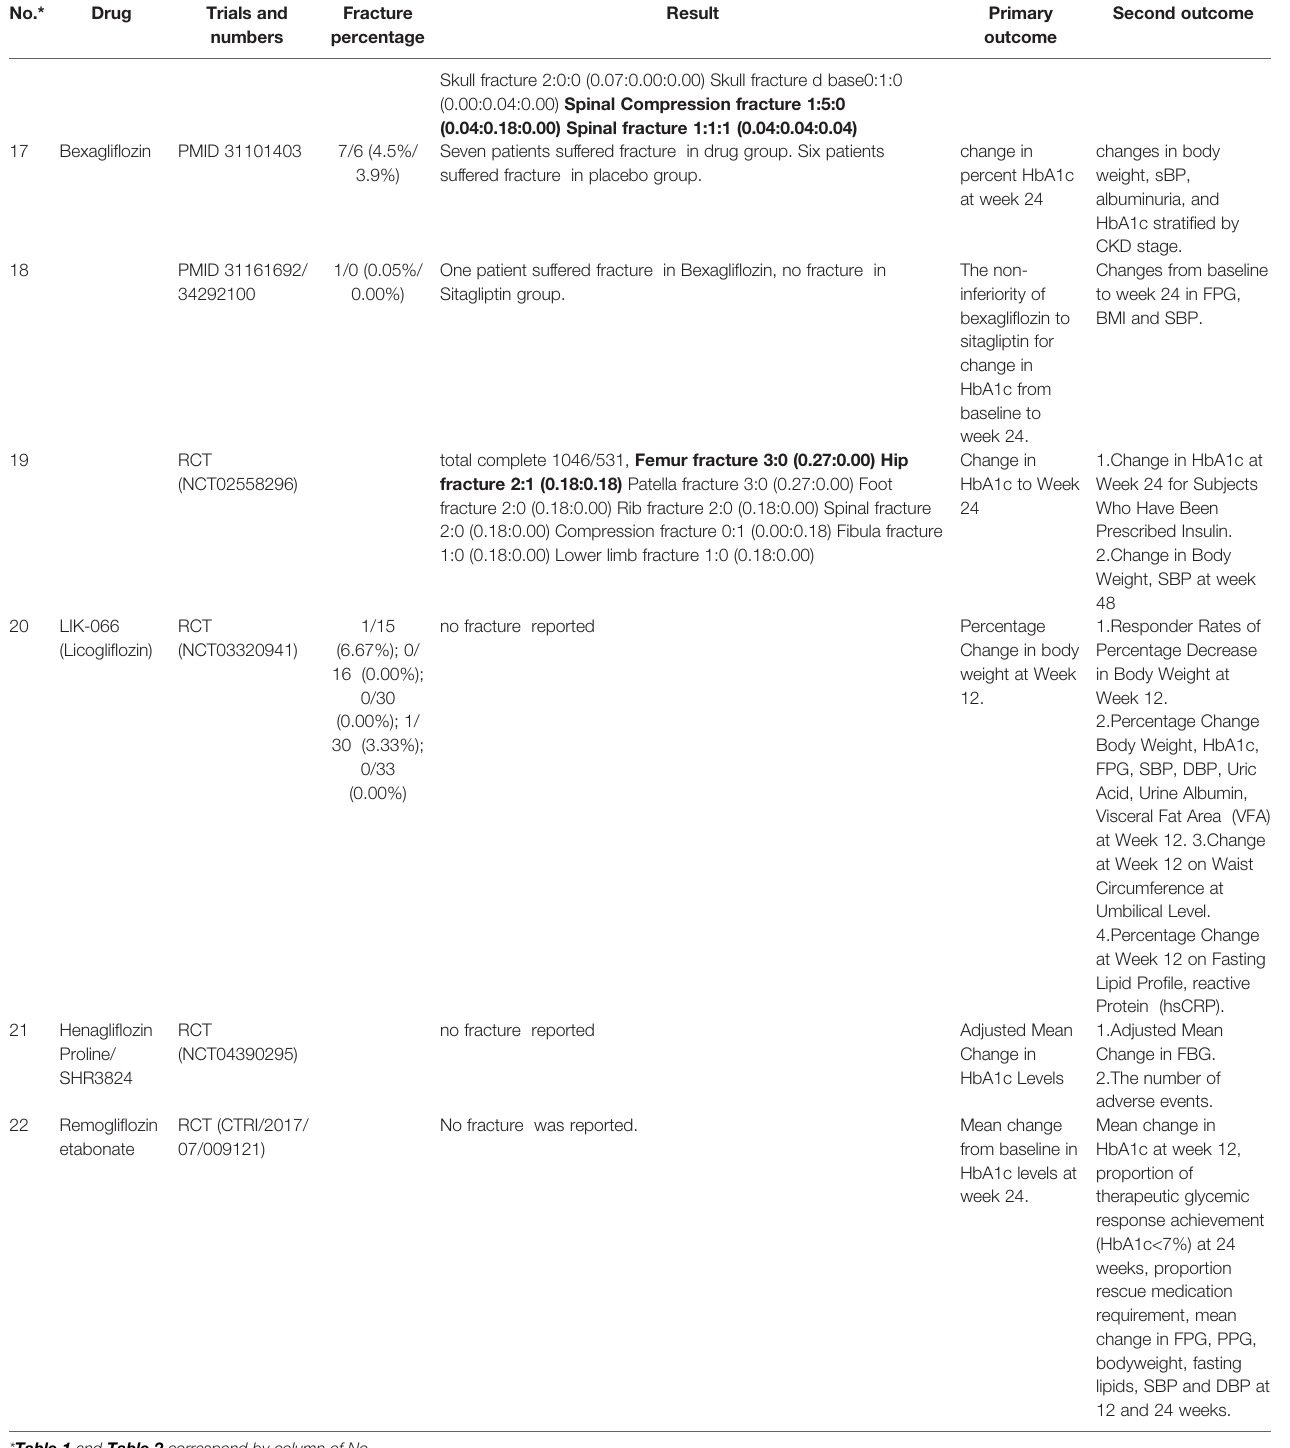
* Table 1 and Table 2 correspond by column of No. *The fi gures in column of Result are all percent. eg. 0.03:0.09 means 0.03%:0.09%. CV, cardiovascular; MI, myocardial infarction; FBG, fasting blood glucose; SBP, Systolic Blood Pressure; DBP, diastolic blood